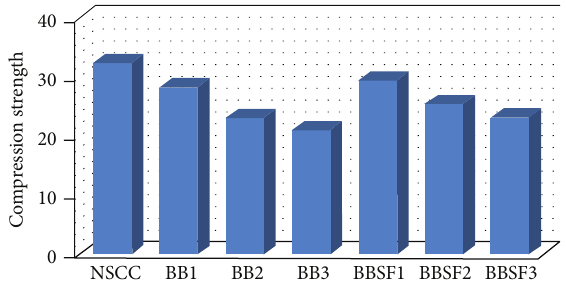
Figure 5: Comparison of the compressive strength.